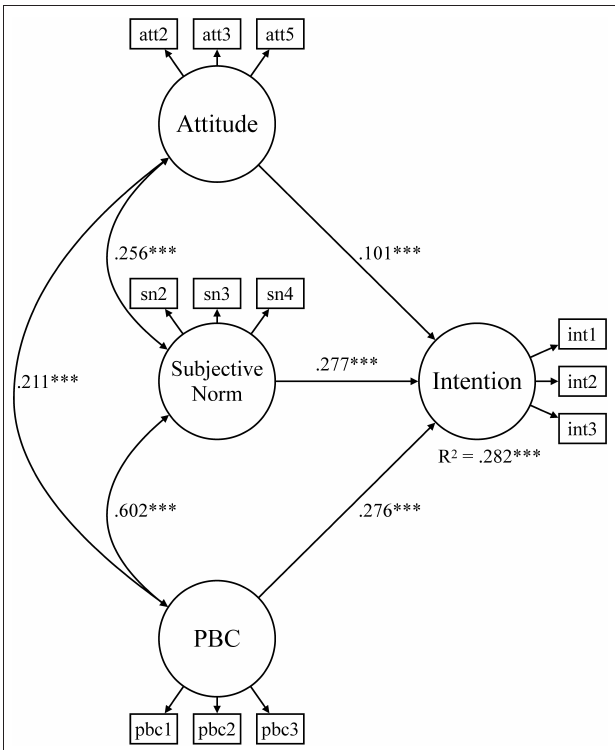
FIGURE 3 | Structural equation model for environmentally friendly behavioral intentions of males. PBC, perceived behavioral control ; *** p <